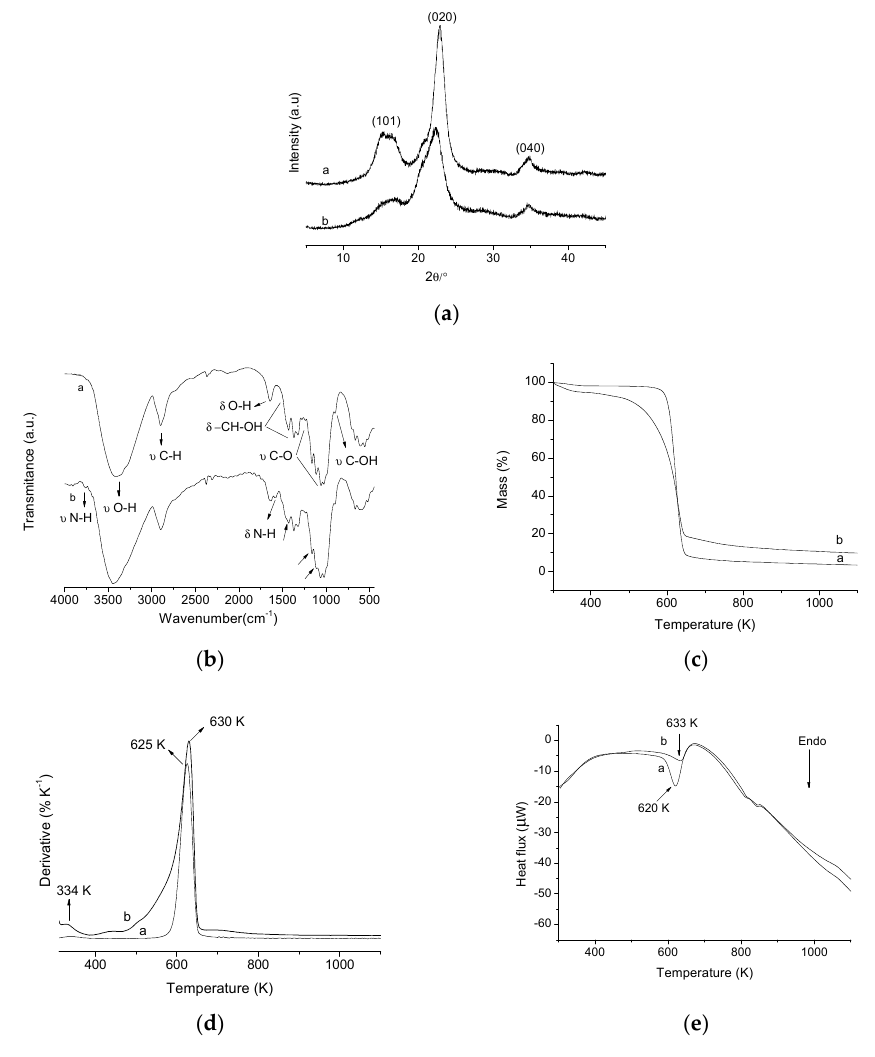
Figure 2. Graphs of X-ray diffraction (XRD) ( a ); fourier transform infrared spectroscopy FTIR ( b ); thermogravimetry (TG) ( c ); derived from thermogravimetry (DTG) ( d ) and differential scanning calorimeter (DSC) ( e ) of the pristine cellulose ( a ) and modified cellulose ( b ).